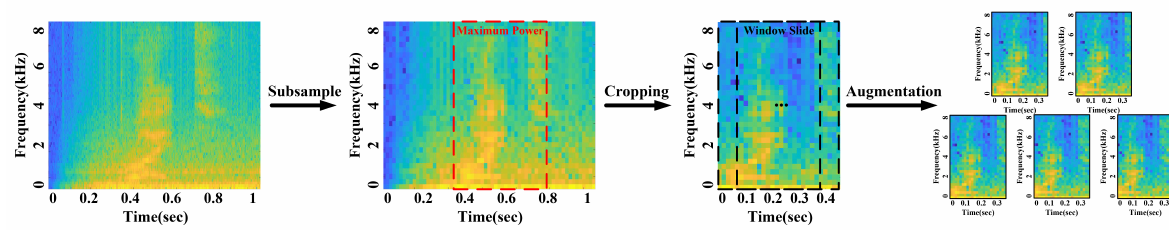
Figure 2. Voice signal processing flow.